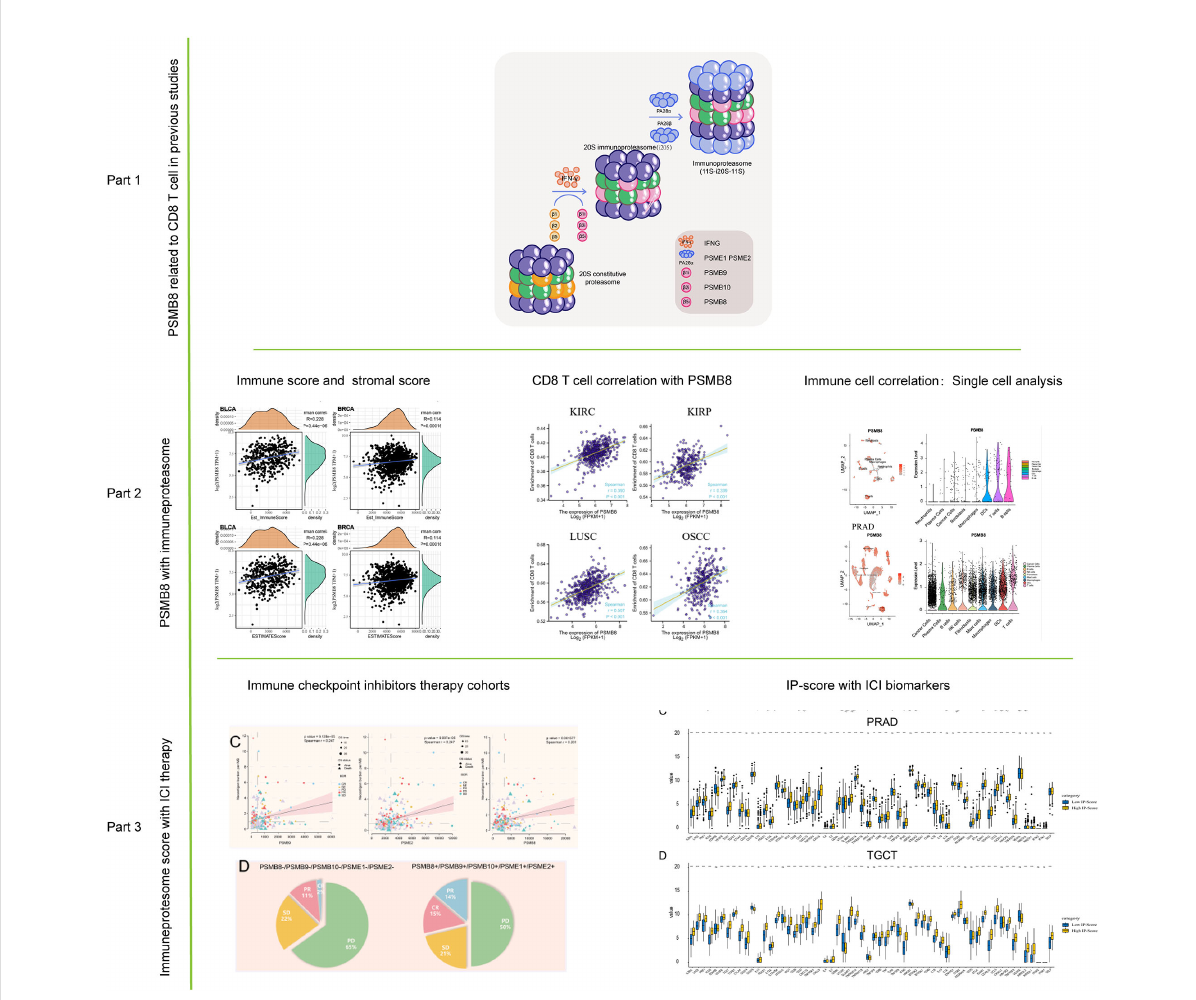
FIGURE 1 Flow chart of this study. The role of PSMB8 in cancer was obtained from previous studies. The correlation analysis of PSMB8 as an important gene of immune proteasome was studied by immune in fi ltration study and single cell analysis. Finally, the role of PSMB8 score in immunotherapy was